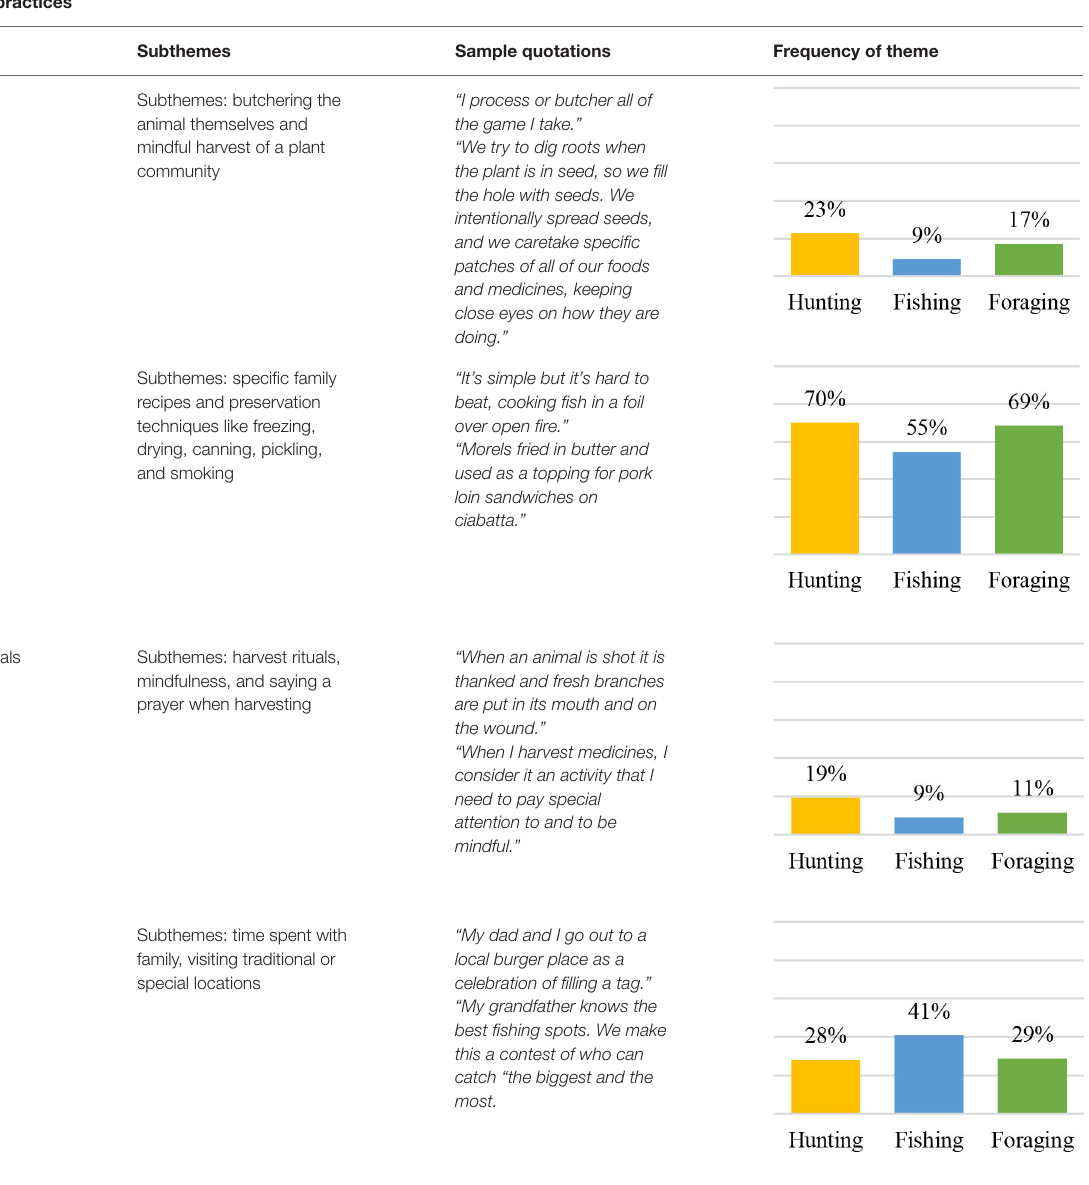
TABLE 3 | Prevalent themes associated with practices and rituals regarding the procurement of wild foods through hunting, fishing, and foraging. Wild food harvesting